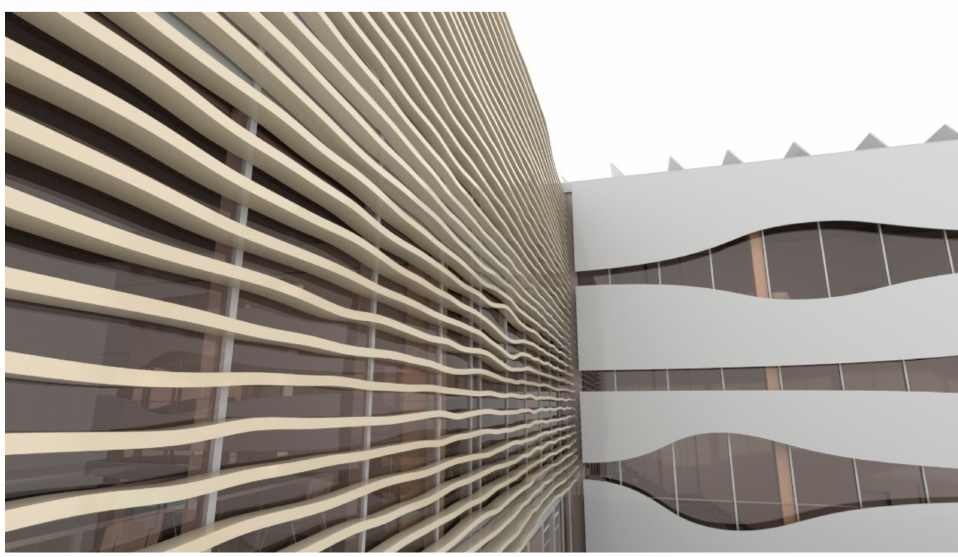
Figure 14. Close-up render of the integrated design